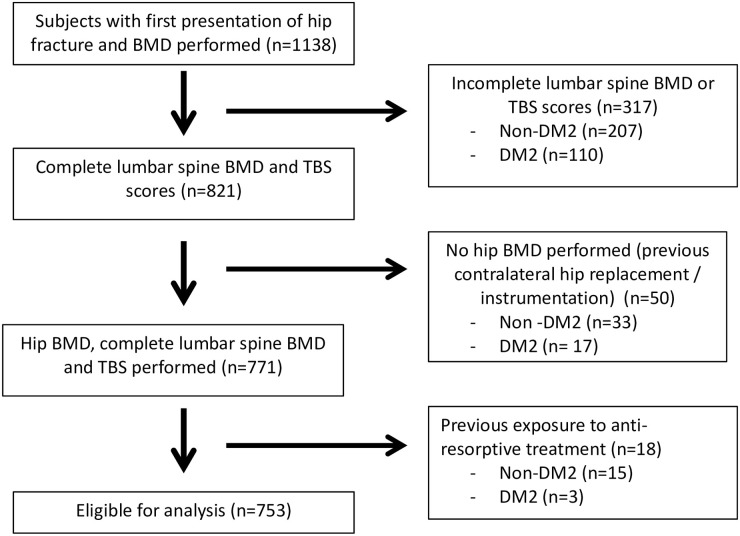
Study subject inclusion and exclusion selection criteria.